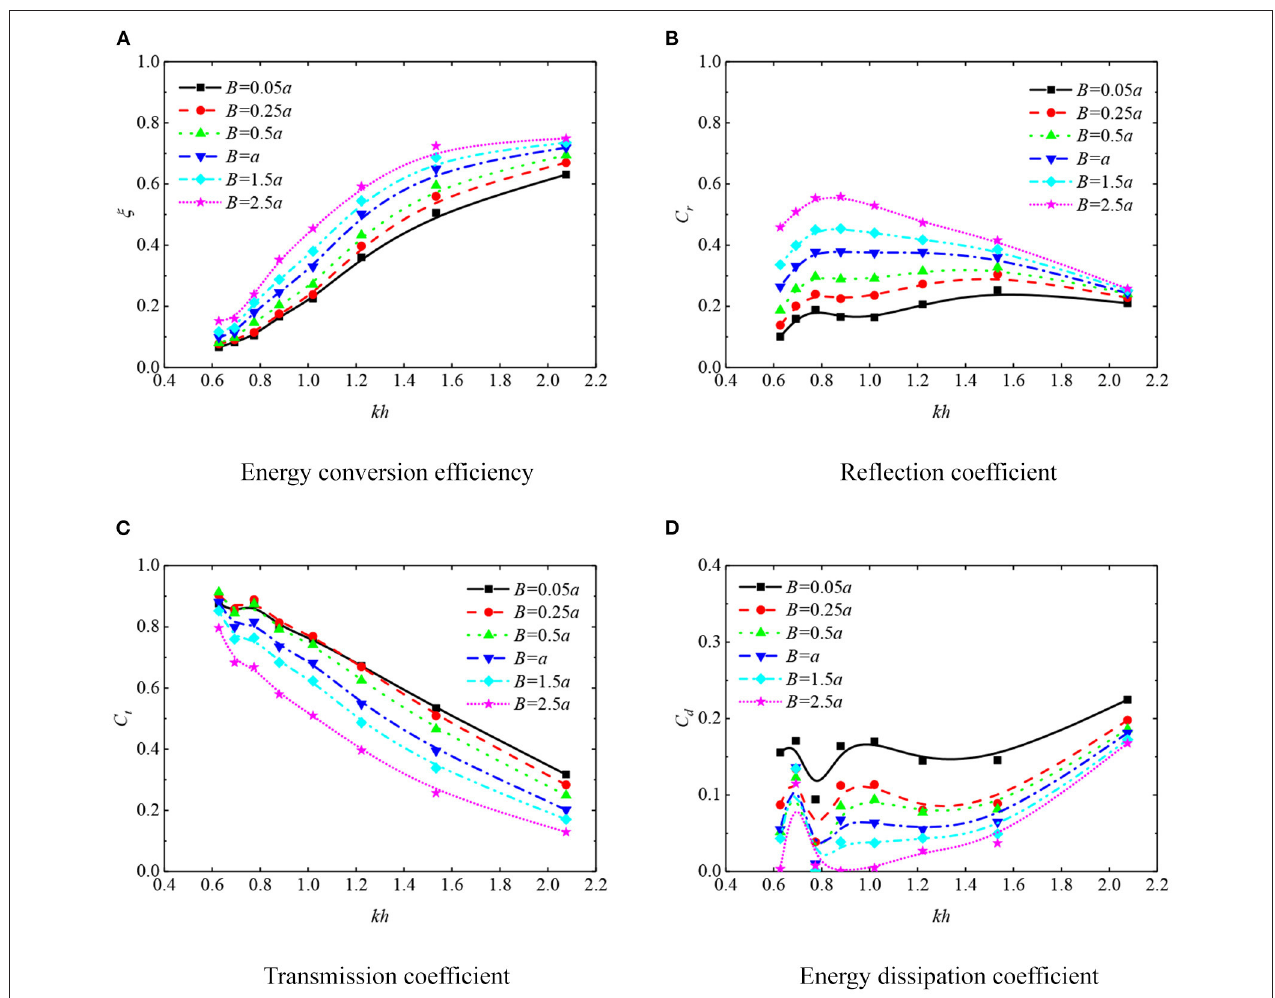
FIGURE 7 | Hydrodynamic coefficients of oscillating water column (OWC) devices with six widths of the rear box under regular waves of H i = 0.05 m. (A) Energy conversion efficiency. (B) Reflection coefficient. (C) Transmission coefficient. (D) Energy dissipation coefficient.